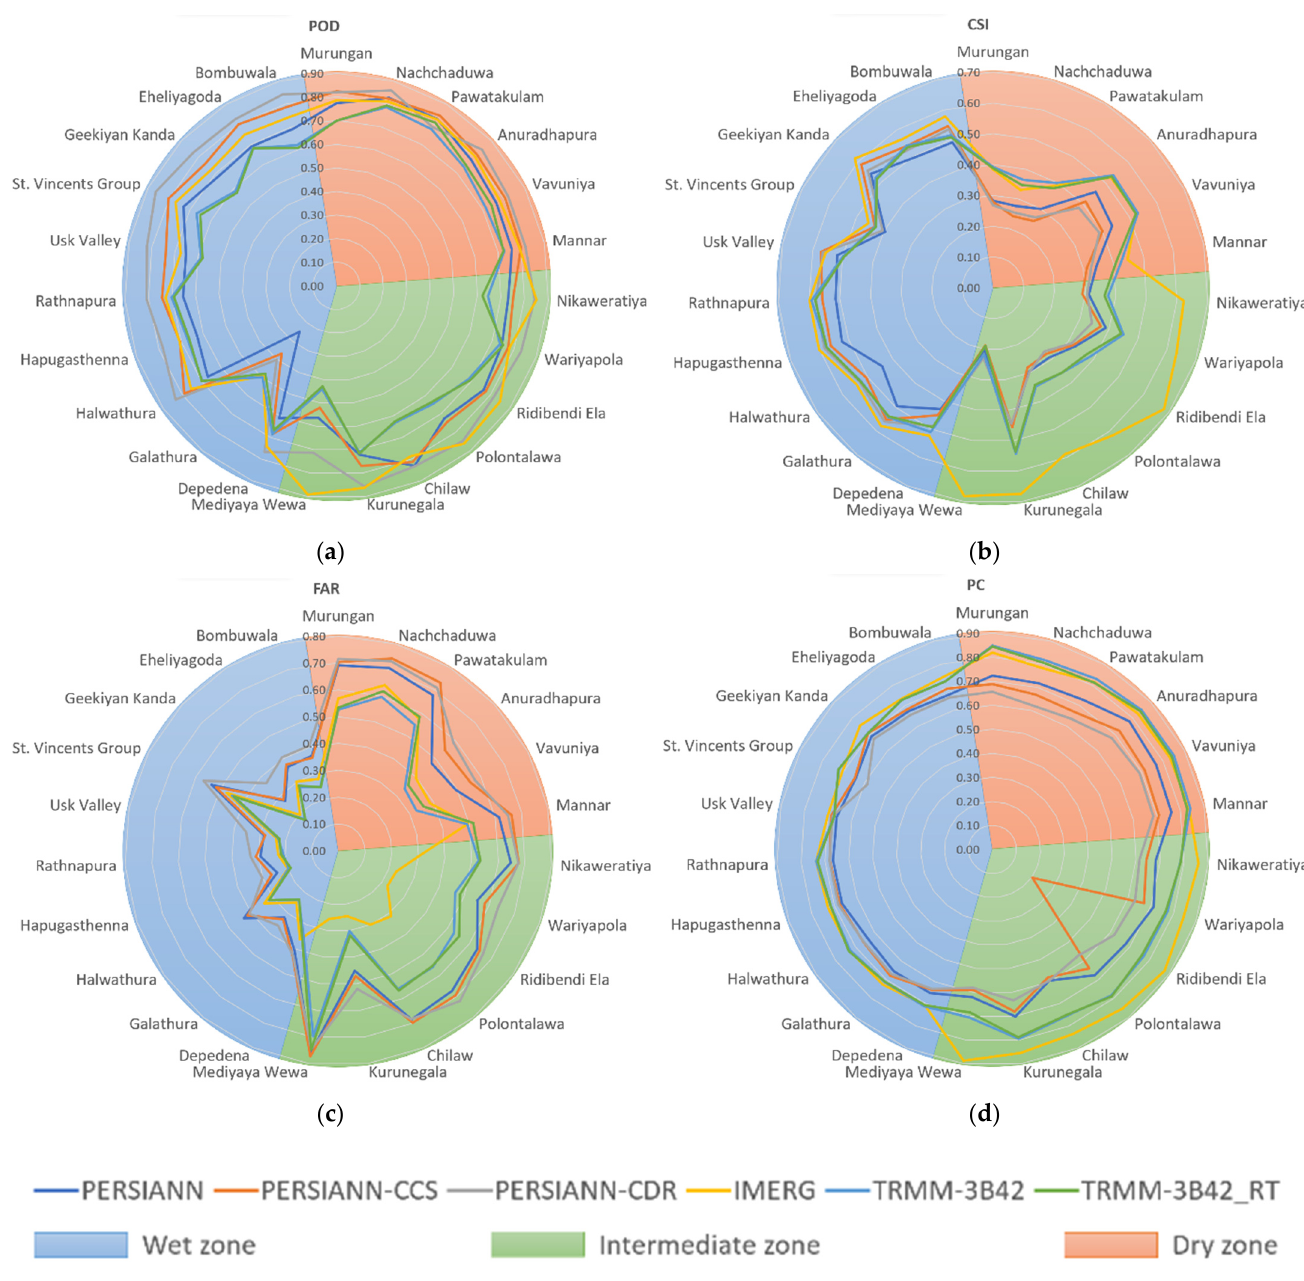
Figure 7. Variations of categorical indices across the basins: ( a ) POD; ( b ) CSI; ( c ) FAR; ( d ) PC.